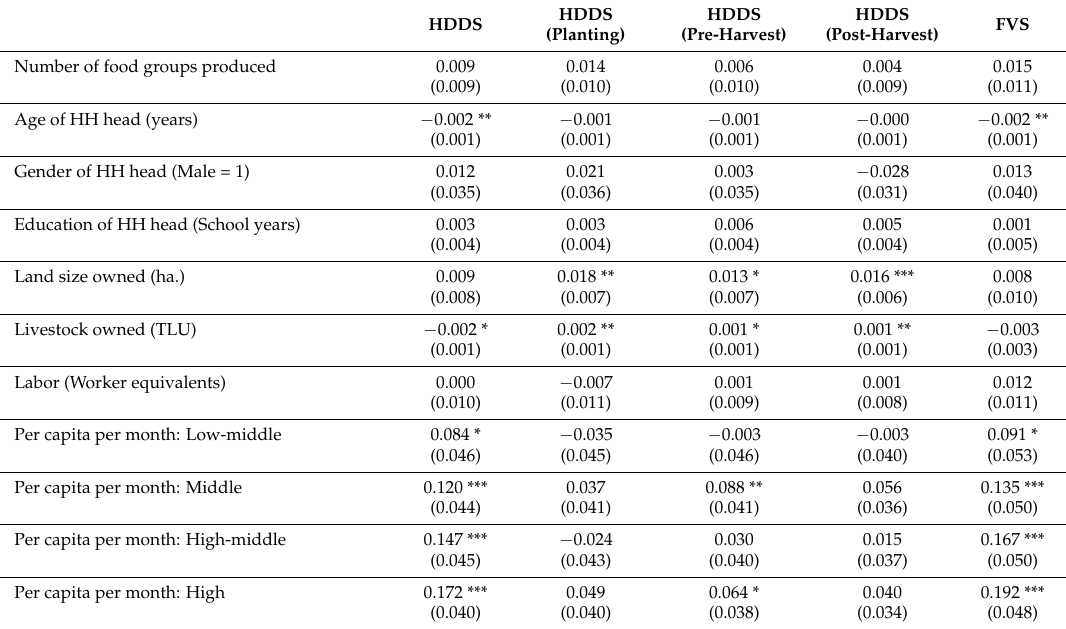
Table A4. Determinants of food consumption diversity in Kilosa (Production diversity indicator used: Number of food groups